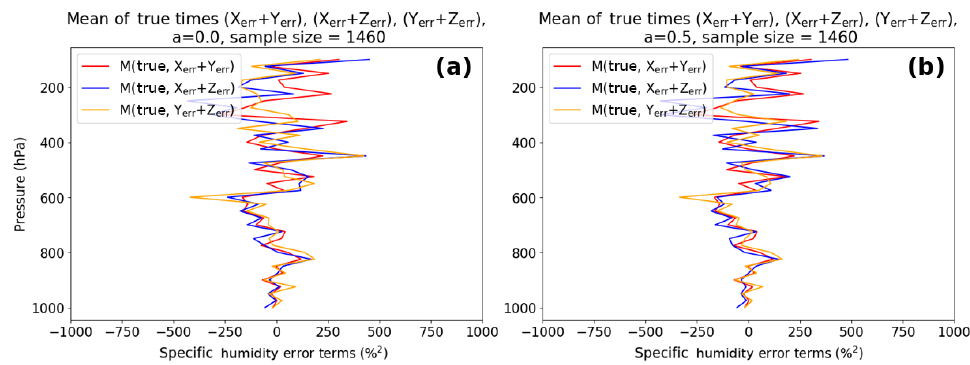
Figure 5. Terms involving products of true and ( X err + Z err ), ( X err + Y err ) and ( Y err + Z err ) for (a) a = 0 and (b) a = 0 . 5. Note that the magnitudes of true and ( X err + Y err ) and true and ( Y err + Z err ) do not depend on the correlation between X err and Z err . All error terms are normalized.